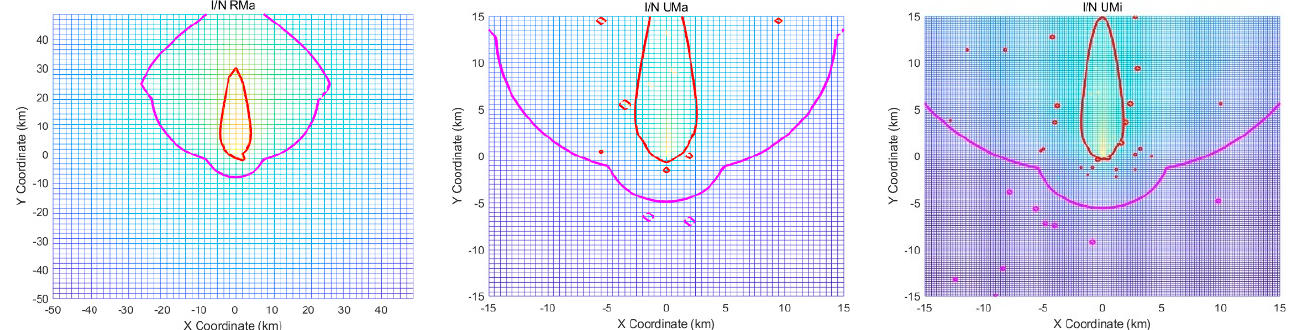
Figure 24. The size of the exclusion and restriction zones for different scenarios using 4 × 4 antenna array.